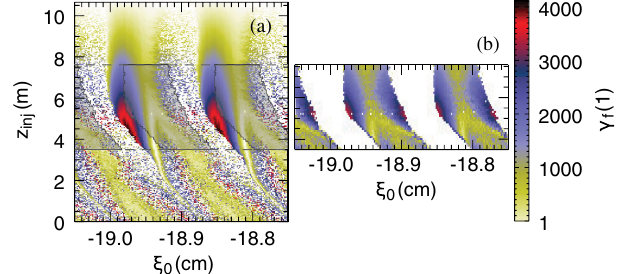
FIG. 8. (a) Final energy of on-axis test electrons that reach the end of the plasma ( z ¼ 10 m) according to their injection point z and their initial position along the bunch ξ 0 , as obtained from inj the 1D pusher, and (b) peak final energy of electrons initially that reach the end of the plasma for several fulfilling r 0 < 0 . 5 k − 1 pe injection points and initial positions, as obtained from a PIC simulation. White areas mean no electrons. The shapes in (b) are superimposed in (a) as shadowed areas, for comparison.